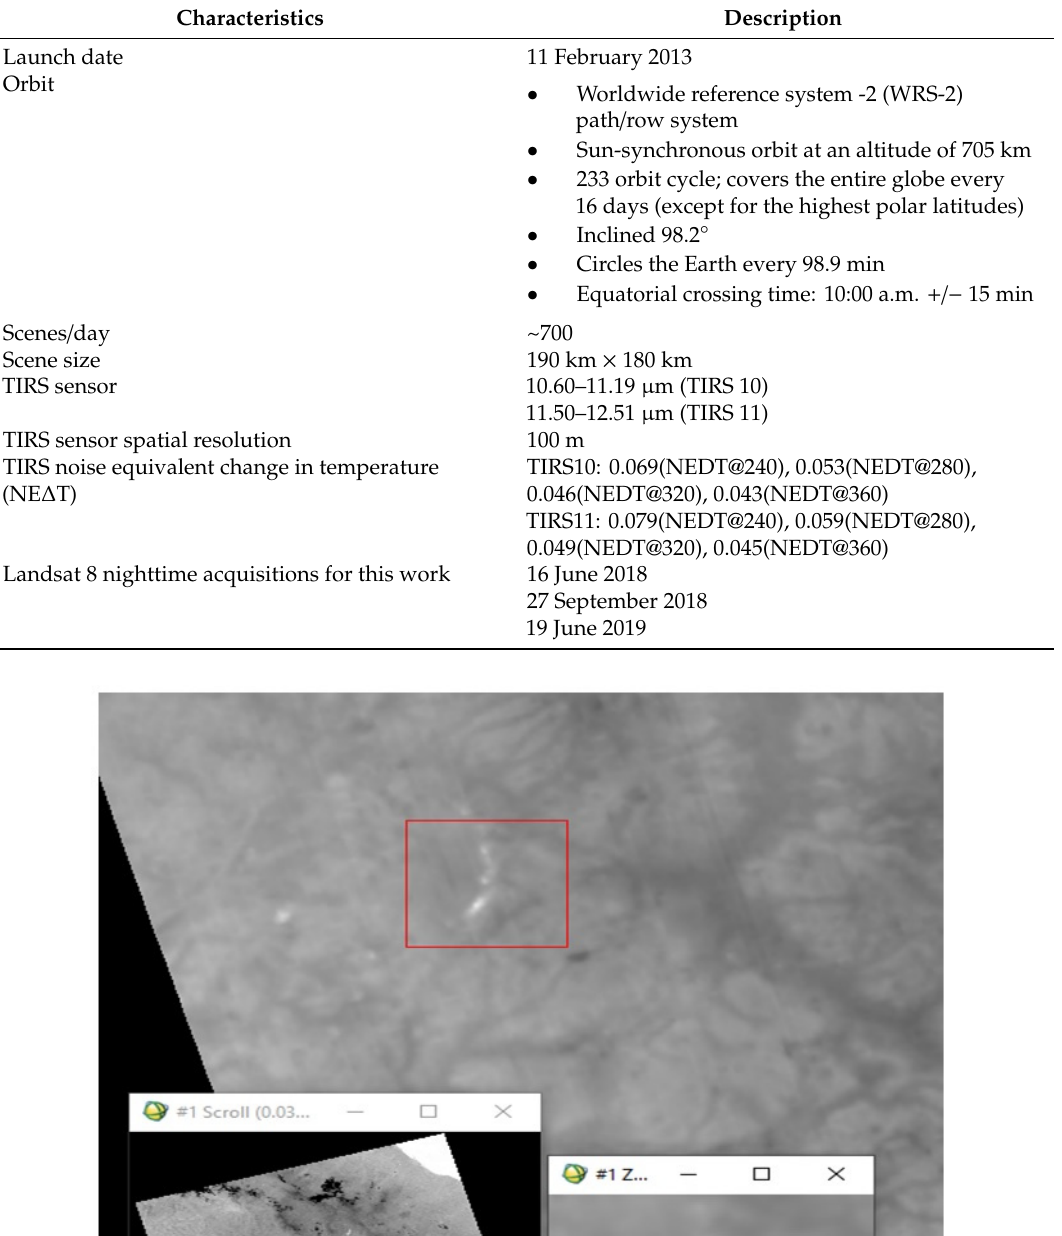
Table 1. Main characteristics of Landsat 8.